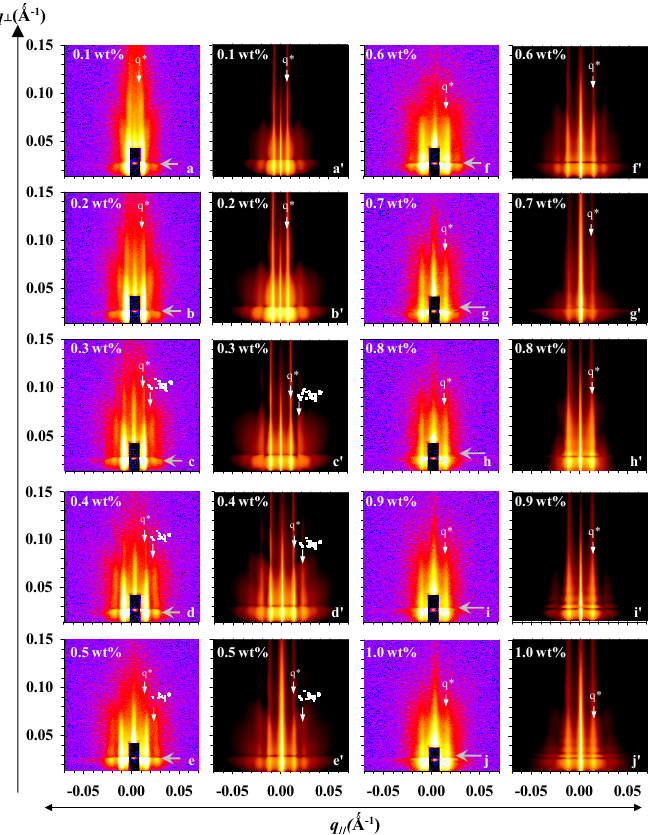
Figure 2. Grazing-incidence small-angle X-ray scattering (GISAXS) patterns ( a – j ) and IsGISAXS simulations ( a ′ – j ′ ) of micellar film on SiO x /Si spun from toluene solutions containing P(S- b -2VP) diblock copolymer at weight fractions: ( a , a ′ ) 0.1; ( b , b ′ ) 0.2; ( c , c ′ ) 0.3; ( d , d ′ ) 0.4; ( e , e ′ ) 0.5; ( f , f ′ ) 0.6; ( g , g ′ ) 0.7; (h , h ′ ) 0.8; ( i , i ′ ) 0.9 and ( j , j ′ ) 1.0 wt %. All of the experimental images show a rod-shaped shadow resulted from the attenuation of a direct beam of X-rays by a copper beam stop. The intensity scale is logarithmic. Bright color (e.g., white & yellow) indicates high intensity of X-ray scattering. Vertical arrows label the positions of the diffraction Bragg’s rods, whereas parallel arrows label the intensity undulation due to the presence of the wetting layer and/or multiple layers.